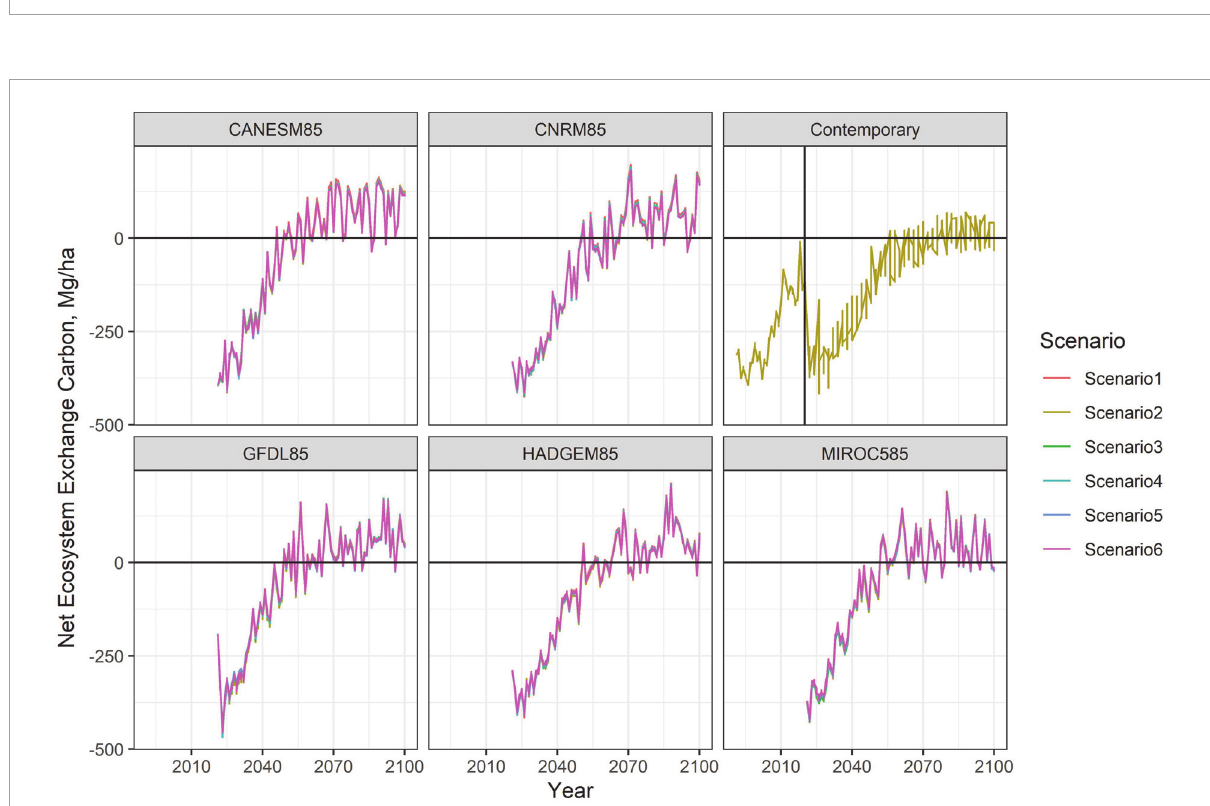
FIGURE6 Carbon: Net Ecosystem Exchange averaged across model replicates by climate projection and management scenario.